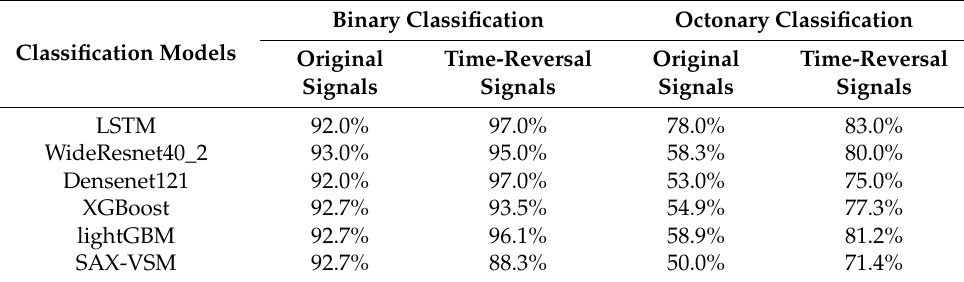
Table 4. Test results obtained using multiple